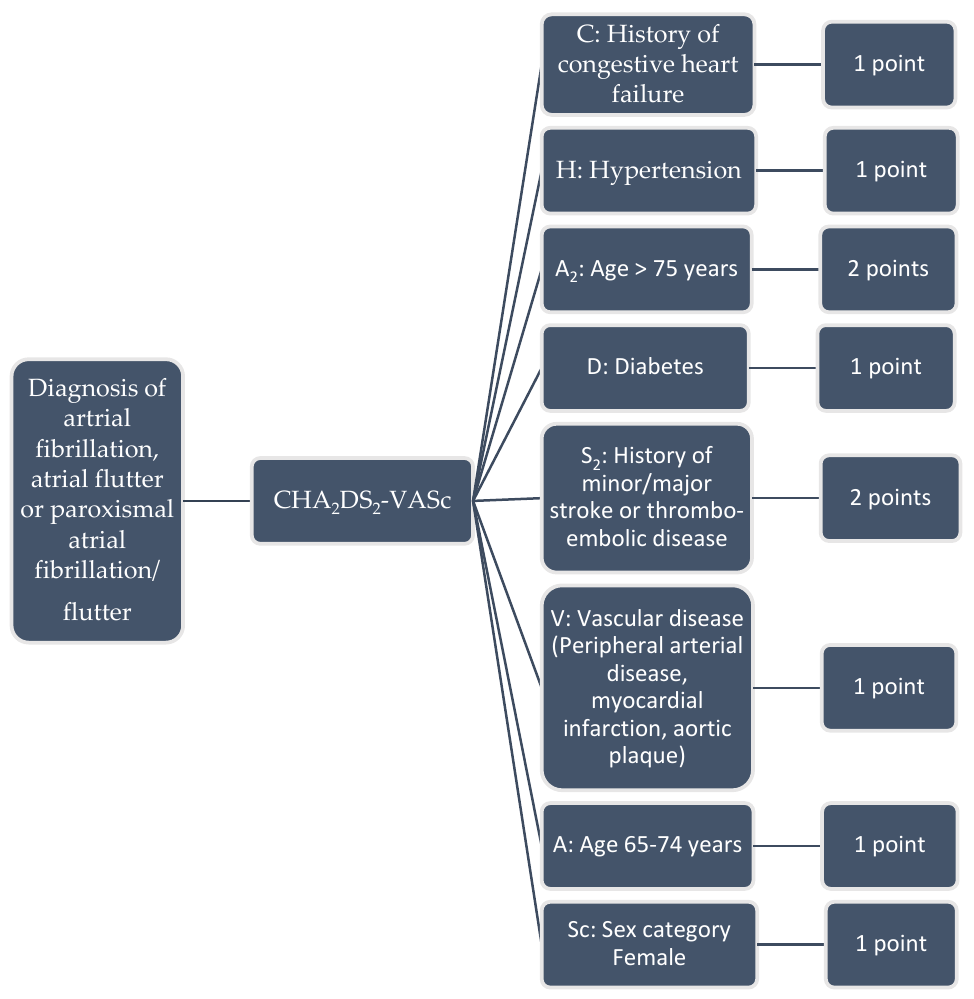
Figure 1. CHA 2 DS 2 -VASc score and scoring system (range 0–10).